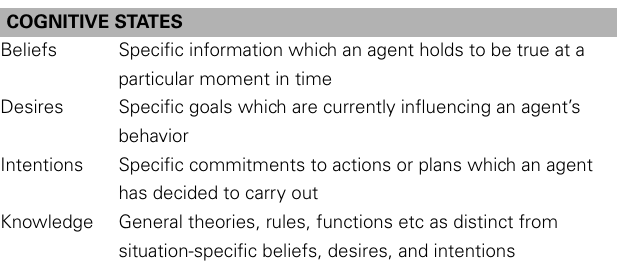
Table 2 | Some of the mental/cognitive states that have been studied inAI.